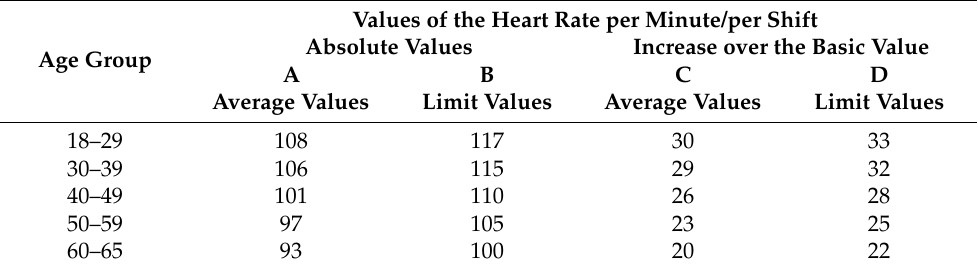
Table 3. Criteria for assessing the heart rate per shift for operations performed predominantly by big muscle groups